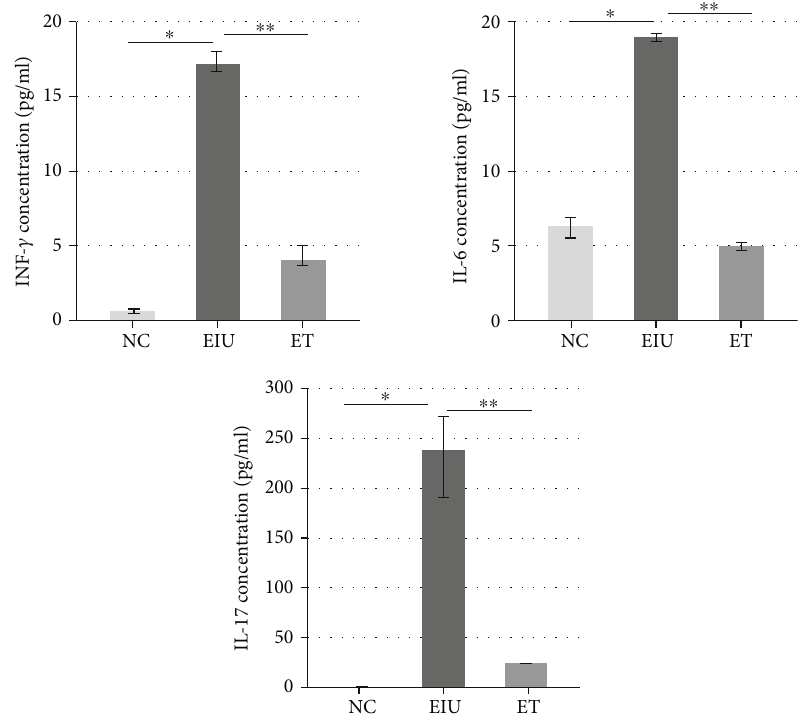
Figure 9: The levels of INF- γ , IL-6, and IL-17 in aqueous humor. INF- γ , IL-6, and IL-17 were signi fi cantly increased in the EIU group ( ∗ P < 0 : 05 ) and signi fi cantly decreased in the ET group (INF- γ : F = 434 : 456 , ∗∗ P < 0 : 05 ; IL-6: F = 346 : 117 , ∗∗ P < 0 : 05 ; IL-17: F = 572 : 173 , ∗∗ P < 0 : 05 ). All data shown as mean ± standard deviation ( n = 20